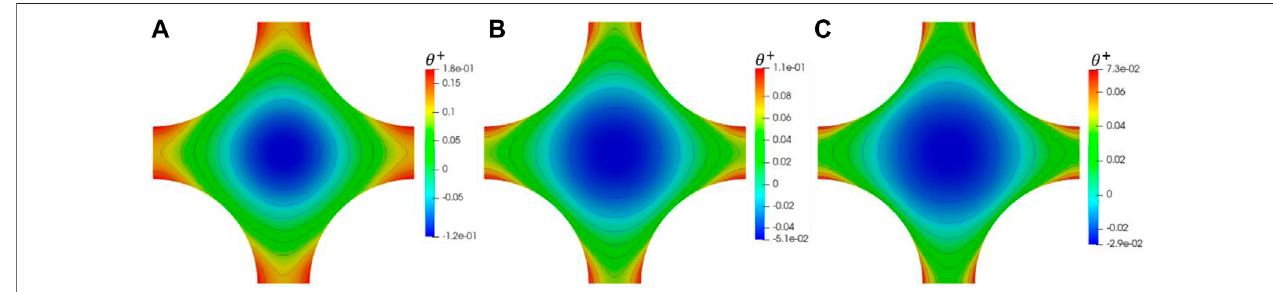
FIGURE 9 | Schematic diagram of dimensionless temperature over lines for the square lattice at Pe = 2000 with different P/D ratios. (A) line ab; (B) line bo; (C) line oc; (D) arc ca.